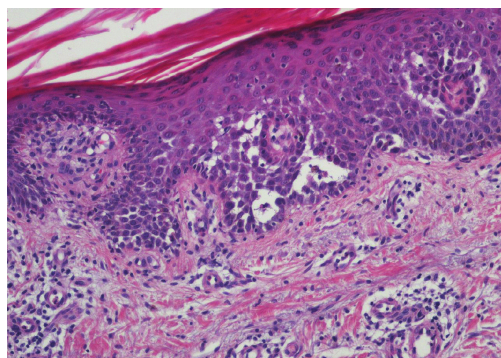
Figure 1: Extensive eruption of erythematous red-brown papulove- sicles lesions scattered over the abdomen and the lower extremities.